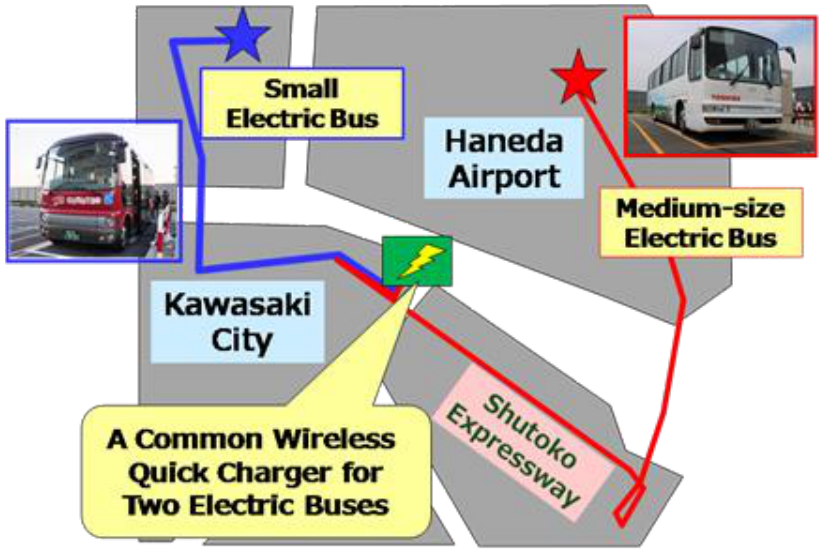
Figure 10. The field test courses in public roads around Haneda Airport and the installation site of 44 kW wireless charging system for two electric buses.